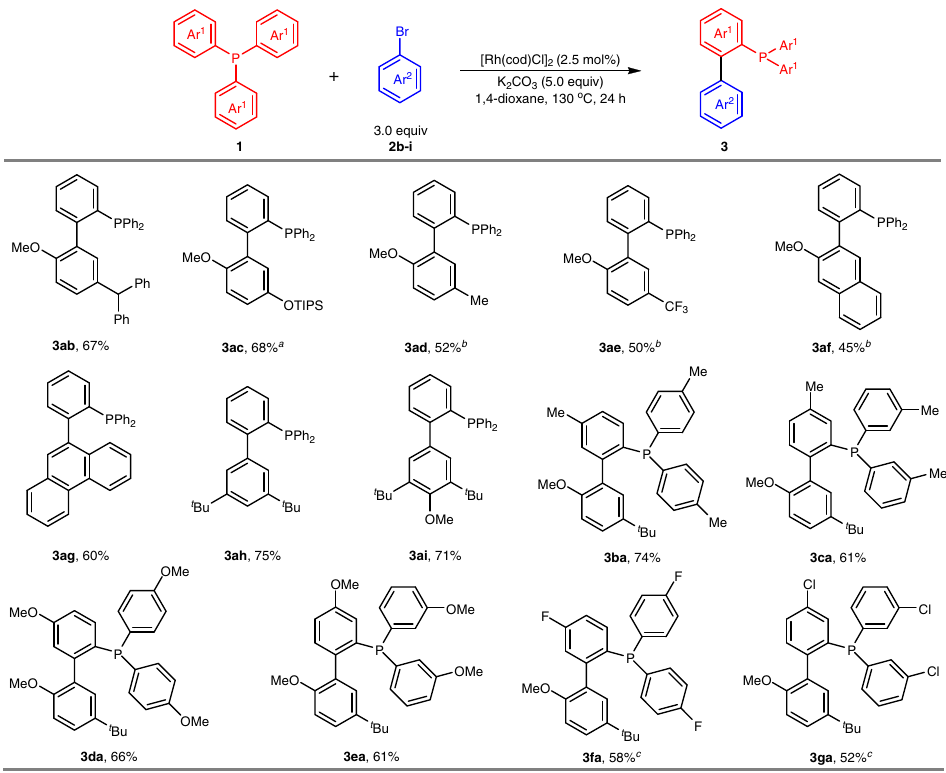
Fig. 2 Substrate scope of one-fold direct arylation. Reaction conditions: [Rh(cod)Cl] 2 (2.5 mol %), 1 (0.2 mmol), 2 (0.6 mmol), K 2 CO 3 (1.0 mmol) in 1,4-dioxane (0.3 mL) at 130 °C for 24 h under argon. a Using [Rh(cod)Cl] 2 (5.0 mol%). b Reaction at 120 °C for 12 h. c Using [Rh(cod) 2 ]OTf (10.0 mol%).